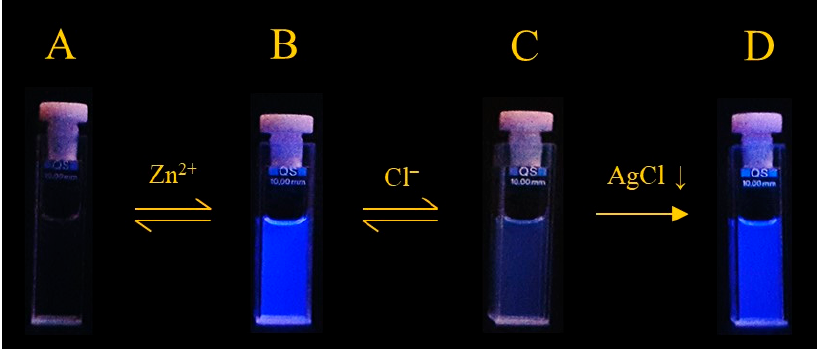
Figure 4. Visual emission fluorescence of solutions containing ( A ) L; ( B ) [ZnL] 2+ ; ( C ) [ZnL] 2+ + 1 equiv. Bu 4 NCl; ( D ) + 1 equiv. AgNO 3 . All solutions in CH 3 CN at 298 K, [L] = 1.35 × 10 − 5 mol·dm − 3 ; images were recorded under a 365 nm UV lamp.